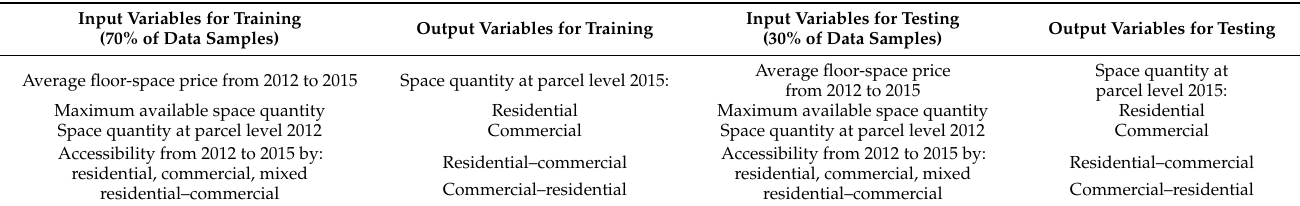
Table 6. Input and output data to the deep neural network model.